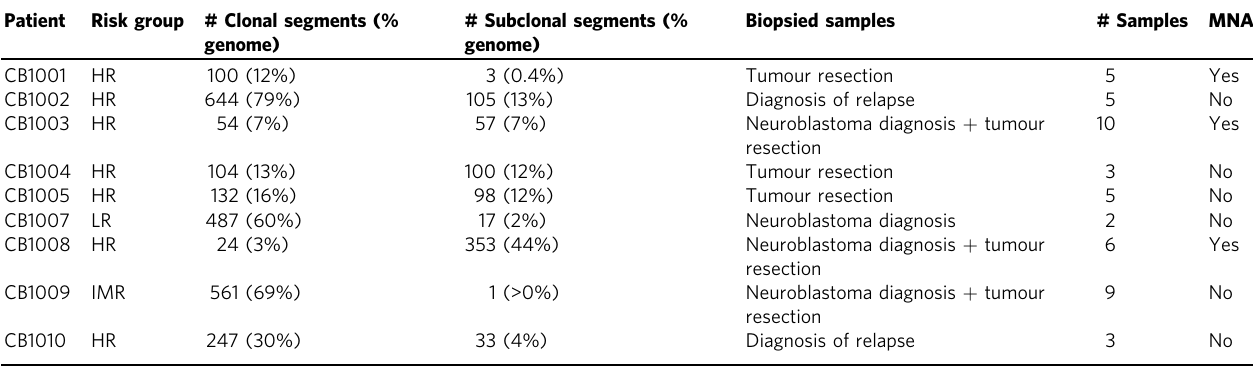
Table 1 Clonality of somatic copy-number alterations identi fi ed in distinct neuroblastoma samples during the course of disease in 9